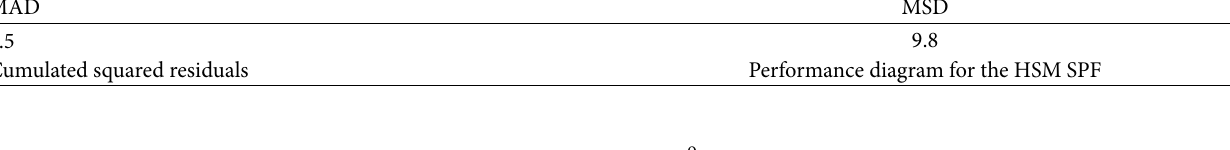
Table 2: Outcomes of the residual’s analysis, applying the HSM SPF to local data.